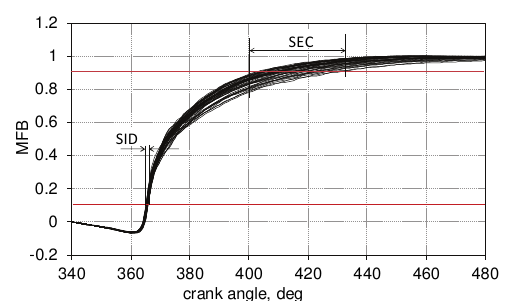
Fig. 8. Mass fraction burned for co-combustion of diesel fuels with ethanol (for 55% of ethanol fraction)